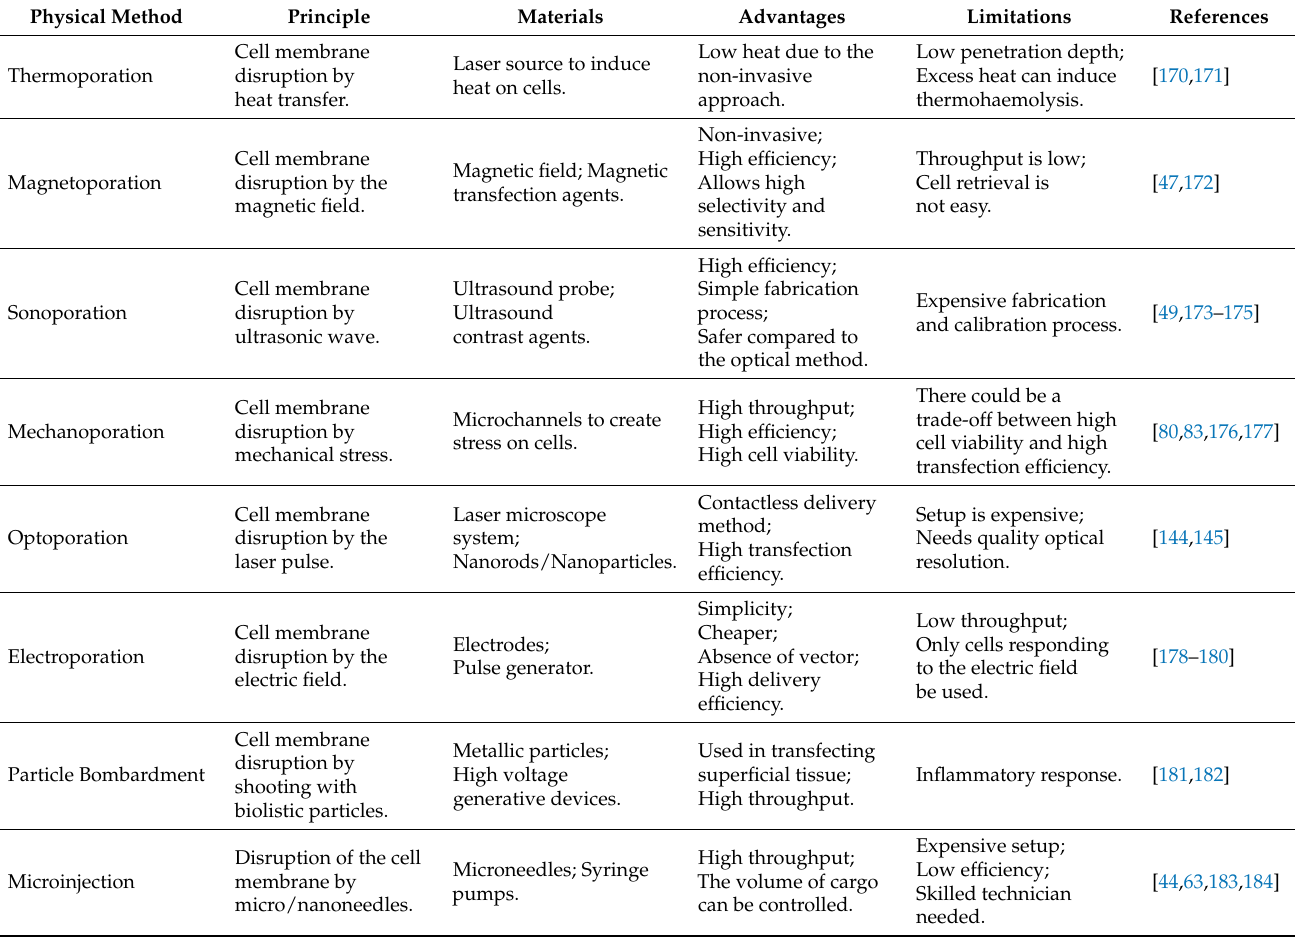
Table 1. Summary of Physical Membrane Disruption